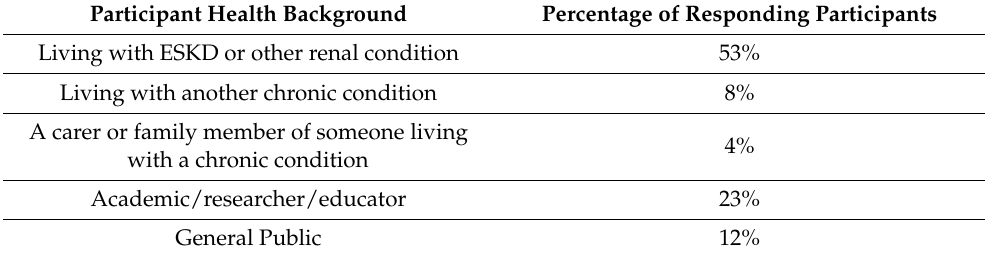
Table 1. Participant Demographics.